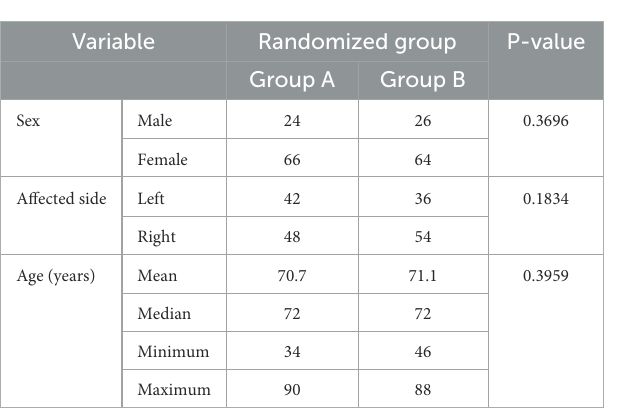
TABLE 1 Patient characteristics.